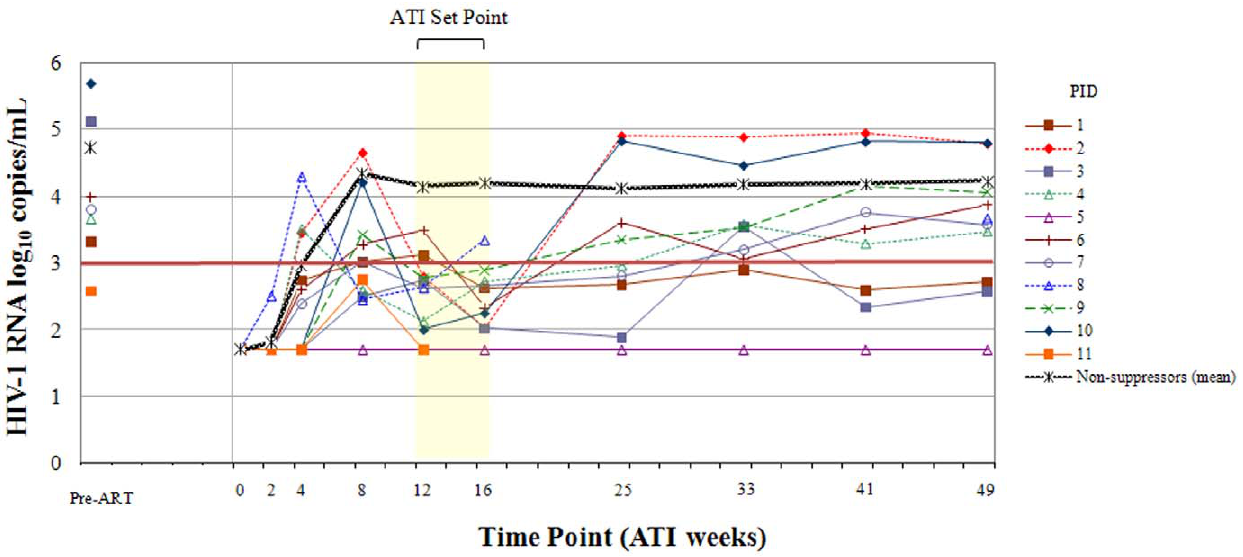
Figure 1. Viral load trends for individuals with ATI set point viral load , 3.0 log10 copies/ml. The light yellow highlighted region encompass the HIV-1 viral load measurements used to calculate the viral set point (mean of the ATI weeks 12 and 16 HIV-1 RNA copies/ml). Pre-ARV, pre-antiretroviral therapy; PID, patient identification number. doi:10.1371/journal.pone.0034134.g001 PLoS ONE |